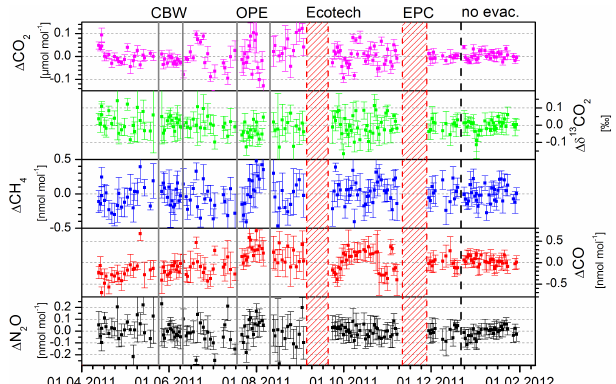
Fig. 6. Measurement residuals with 1 σ error bars relative to a ref- erence value for a single target tank over a 10 month period (from Hammer et al., 2012). During this period, the FTIR analyser was based in Heidelberg except for two field campaigns at Cabauw, Netherlands (CBW) and Houdelaincourt, France (OPE). “Ecotech” refers to a rebuild of the instrument to include the mass flow con- troller (Sect. 2), and “EPC” refers to the addition of an electronic pressure controller upstream of the analyser in the sample airstream. “No evac” refers to a period where ambient and target gas in the cell was exchanged by switching flow alone, without evacuation of the